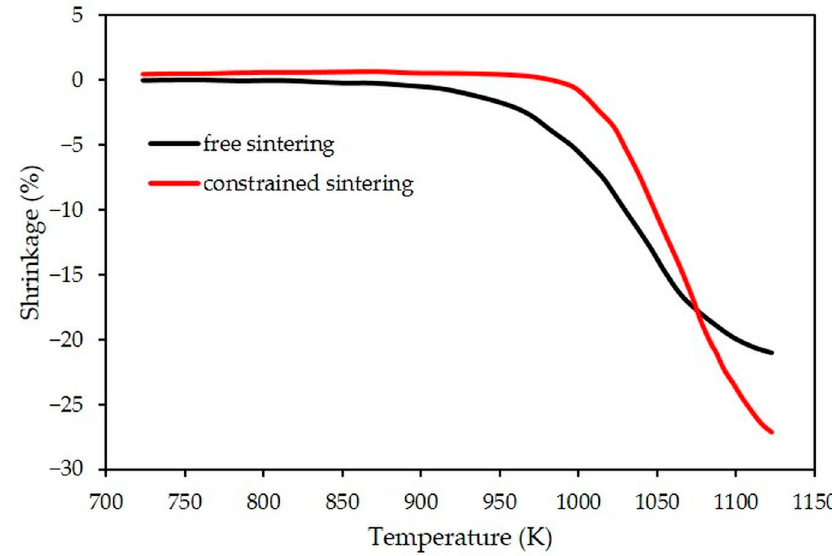
Figure 6. Evolutions in temperature of out-of-plane shrinkage (thickness direction) for free (measured) and constrained (simulated) sintering.